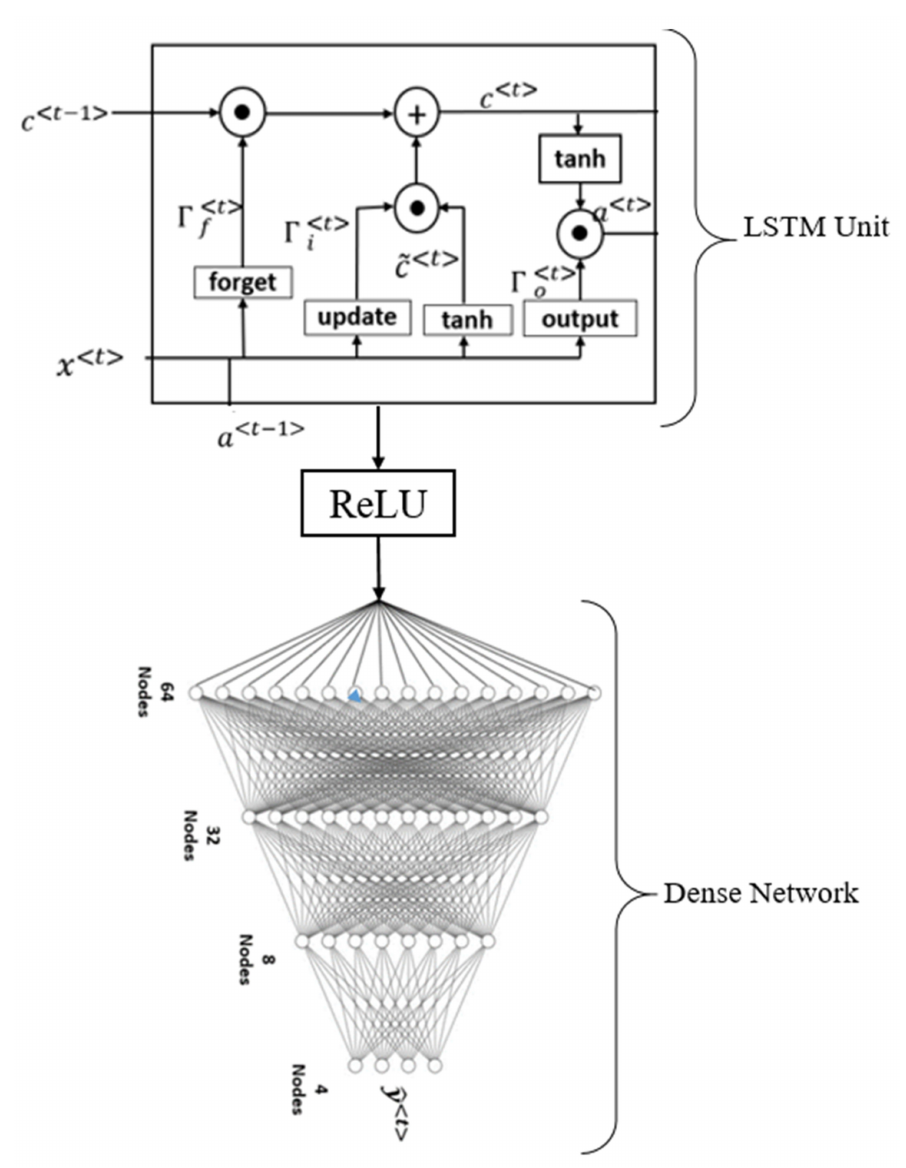
Figure 15. The general structure of LSTM architecture